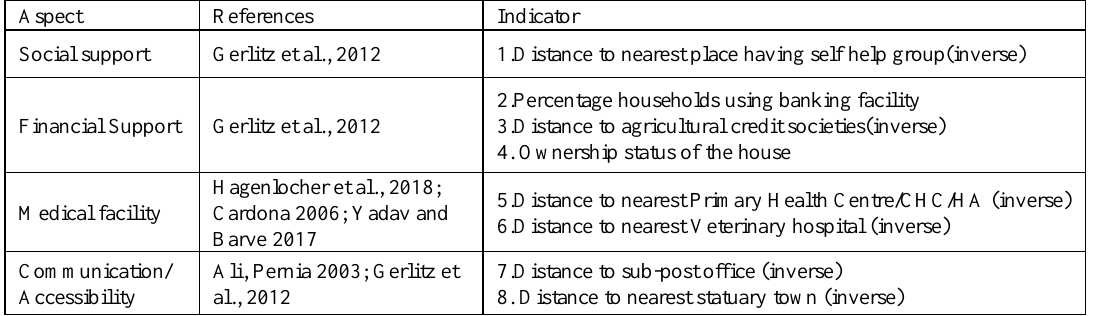
Table 4. Sub-dimensions, indicators and references for coping